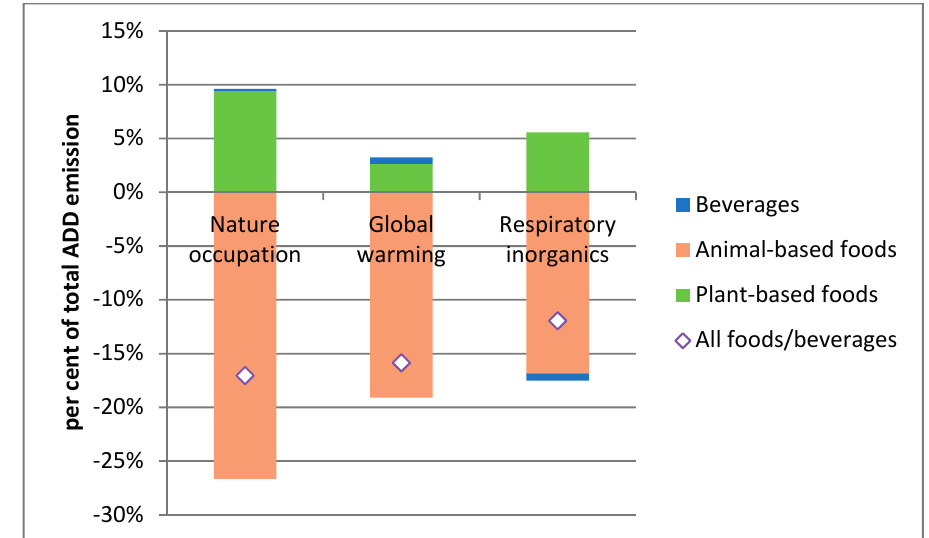
Figure 1. Effects of NND on most important environmental externalities.